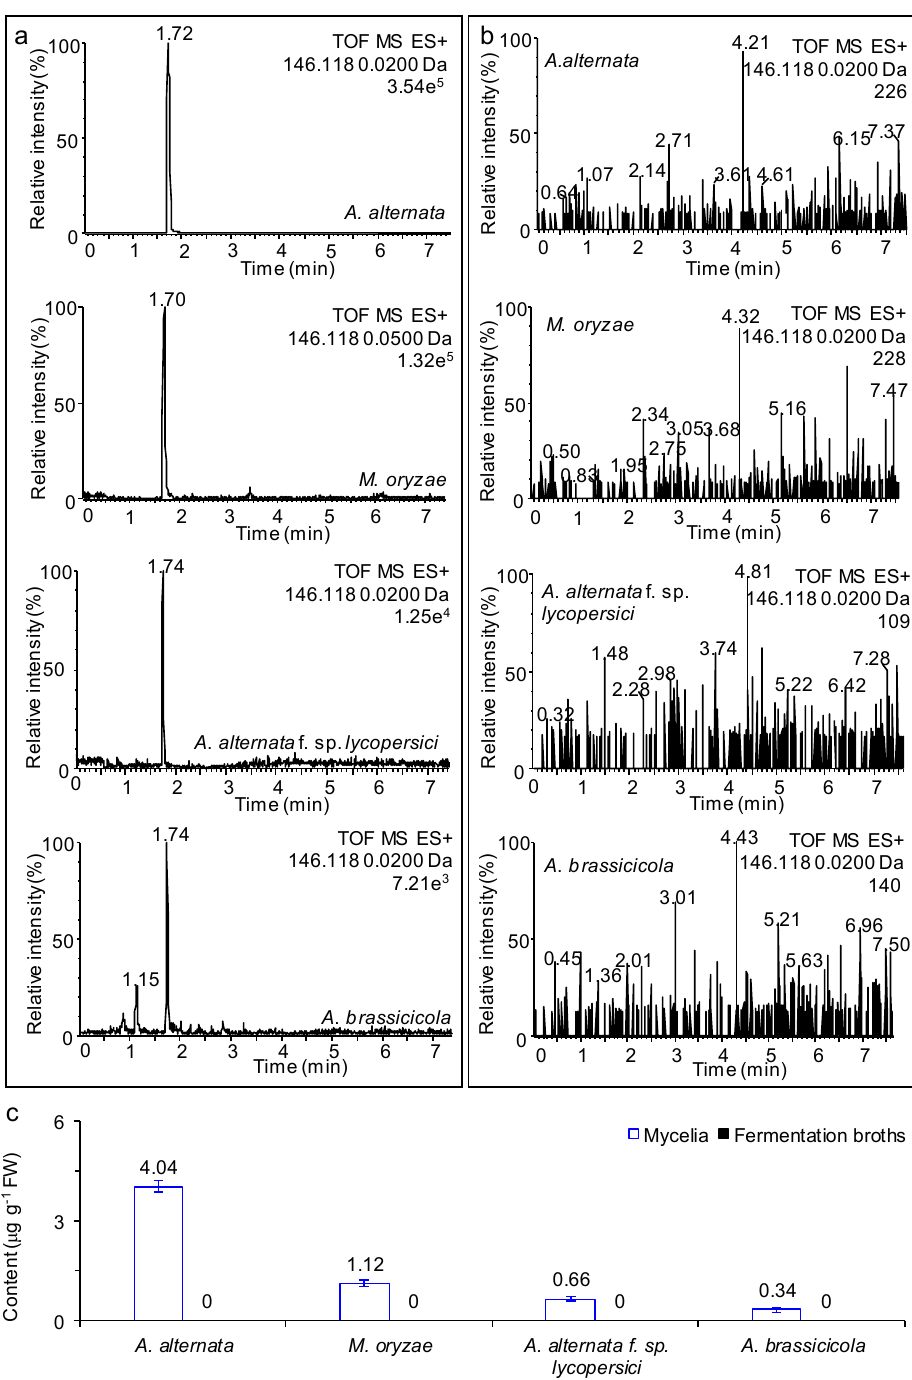
Figure 4. Natural production of AMHA by mycelia and fermentation broths of four fungi. A. alternata , M. oryzae , A. alternata f. sp. lycopersici and A. brassicicola cultivated for 7 d on Czapek liqiud medium. Results represent three independent biological replicates. ( a ) UPLC–MS chromatogram in positive ion mode of extracts of mycelia of four fungi. ( b ) UPLC–MS chromatogram in positive ion mode of filtrate of fermentation broths of four fungi. ( c ) Content of natural AMHA in the mycelia and fermentation broths of four different fungi at 7 d of cultures on Czapek liquid medium.